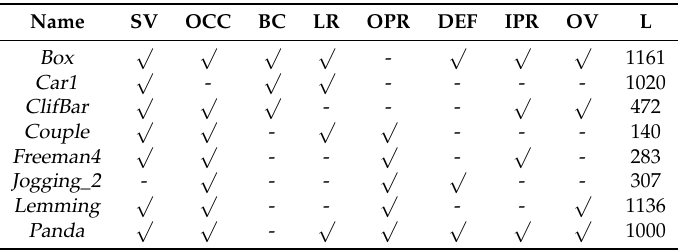
Figure 8. Tracking screenshoots of six state-of-the-art trackers and our tracking algorithm on 8 challenging sequences from OTB-2015 (from left to right and top to down are Box , Car1 , ClifBar , Couple , Freeman4 , Jogging_2 , Lemming and Panda , respectively). The number in top left corner denotes frame index. Our algorithm is marked as red, we recommend checking this figure in color and amplification mode. Table 5. Challenges of the experimental